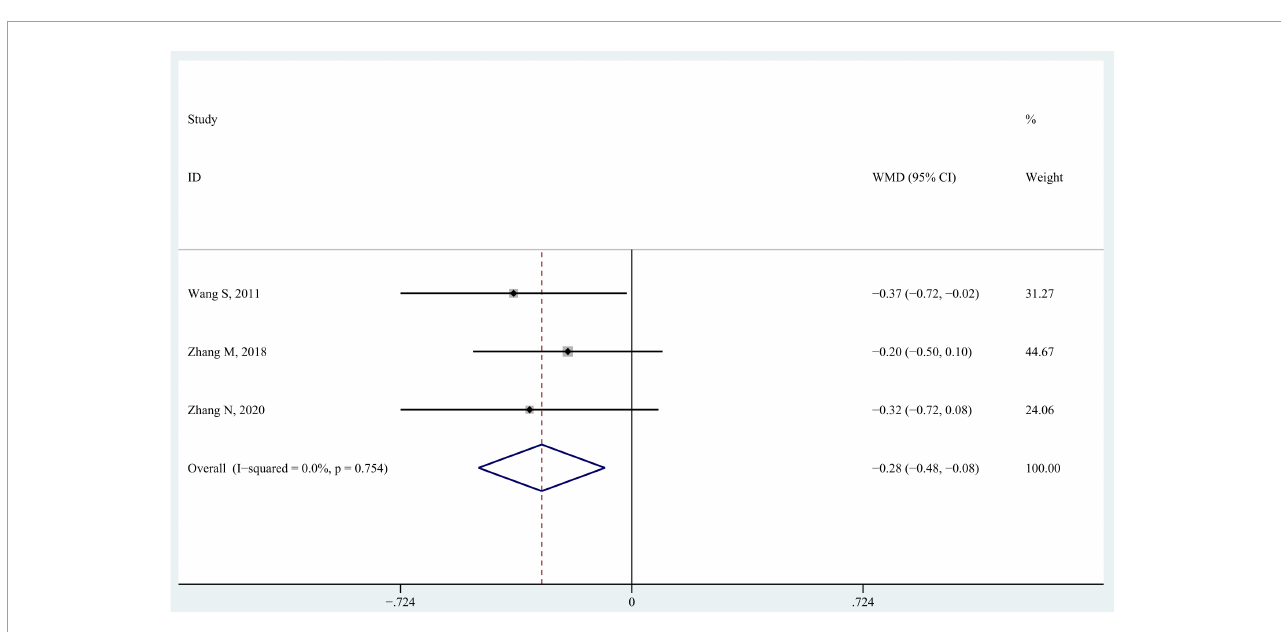
FIGURE5 Forest plot of pooled results for modified Ashworth